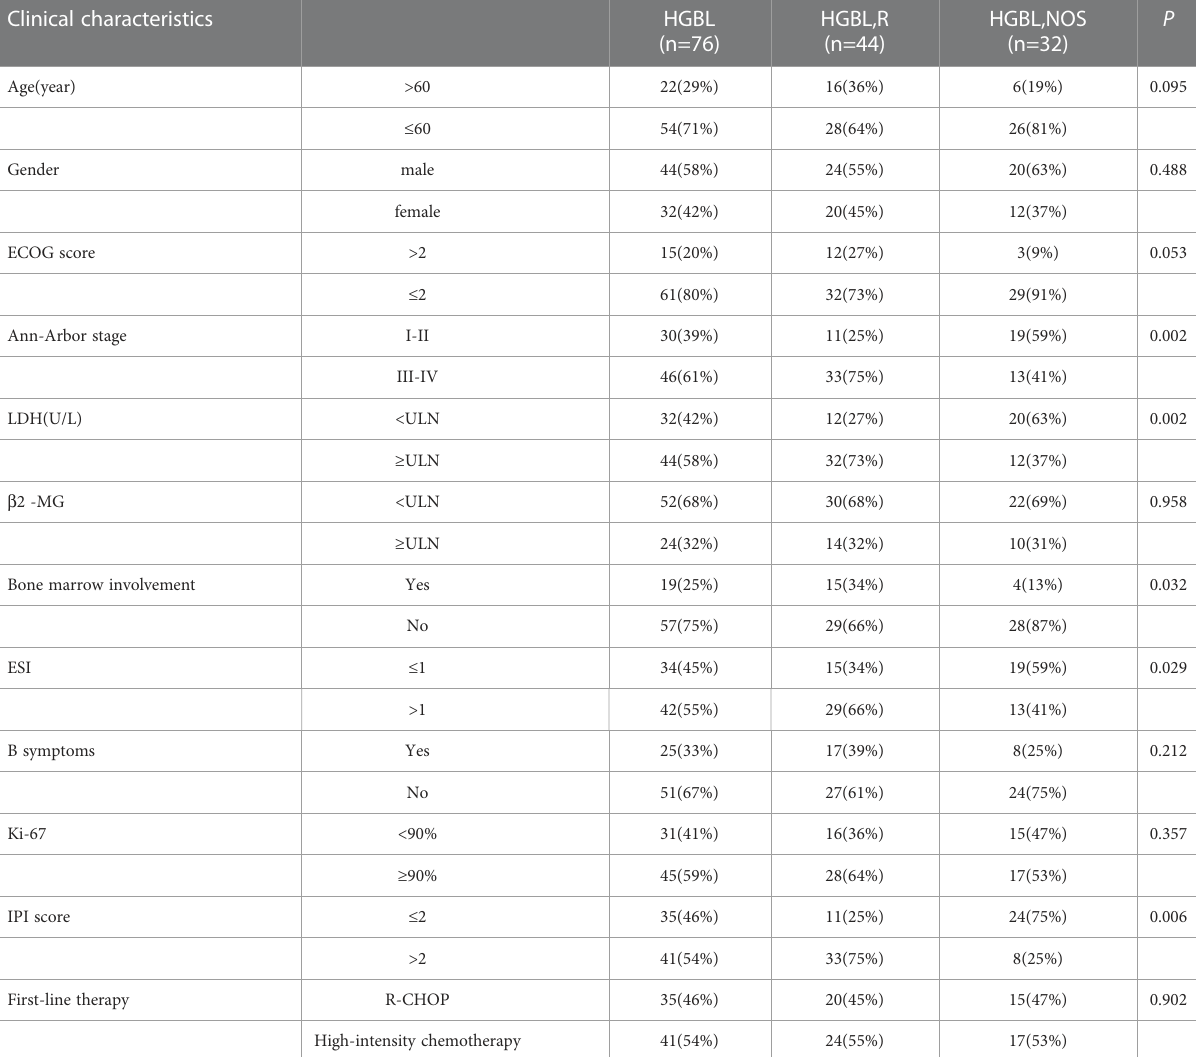
TABLE 2 The comparison of clinical characteristics between the two